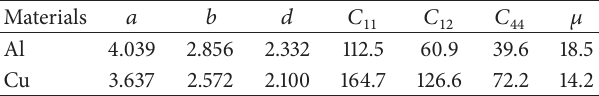
Table 1: The lattice constants 𝑎 , Burgers vector 𝑏 and distance between slip planes 𝑑 (in units of ˚A), elastic constants 𝐶 11 , 𝐶 12 , and 𝐶 44 (in units of GPa), and shear modulus